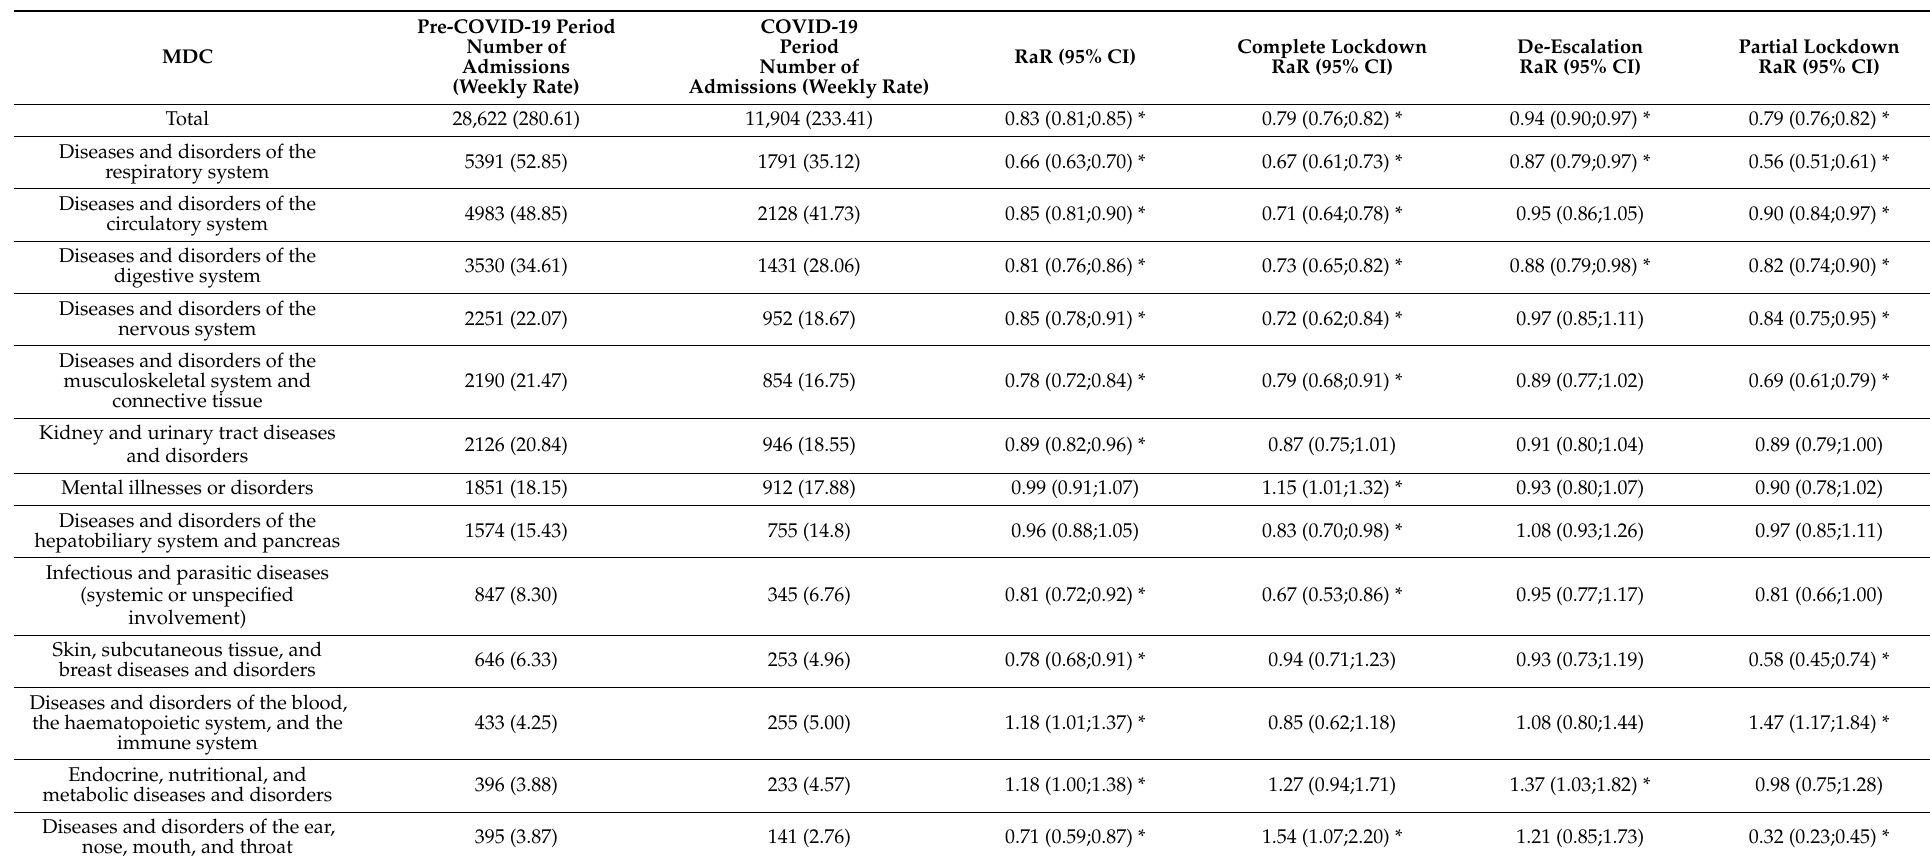
Table 2. Rate ratio of weekly number of admissions between pre-COVID and COVID periods by Major Diagnostic Categories (MDC). Weekly number of admissions pre-COVID-19 = number of unplanned emergency admissions/number of weeks pre-COVID period (2018–2020). Weekly number of admissions COVID-19 =